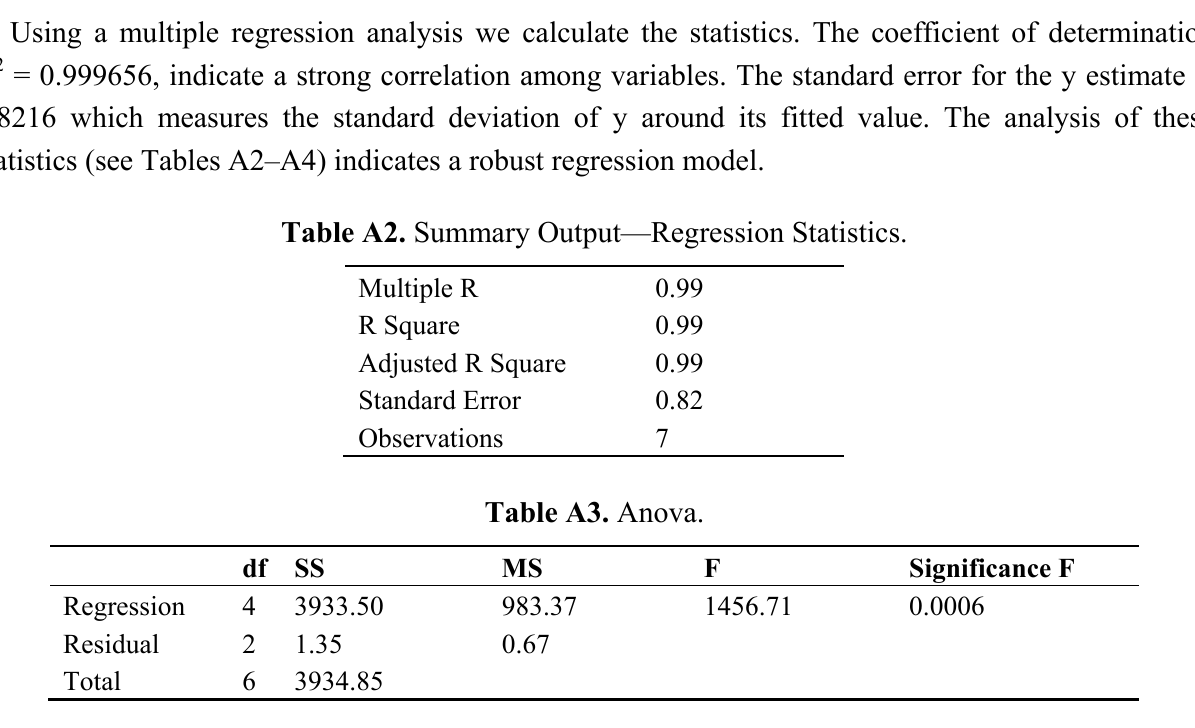
Table A4. Regression